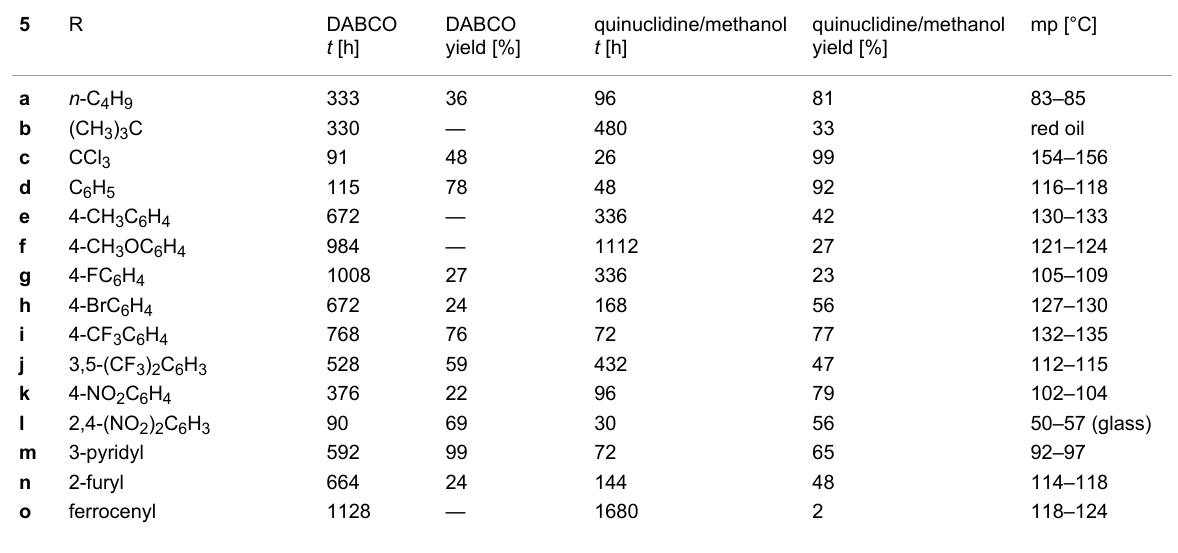
Table 1: Yields and melting points (mp) of MBH adducts 5a – o